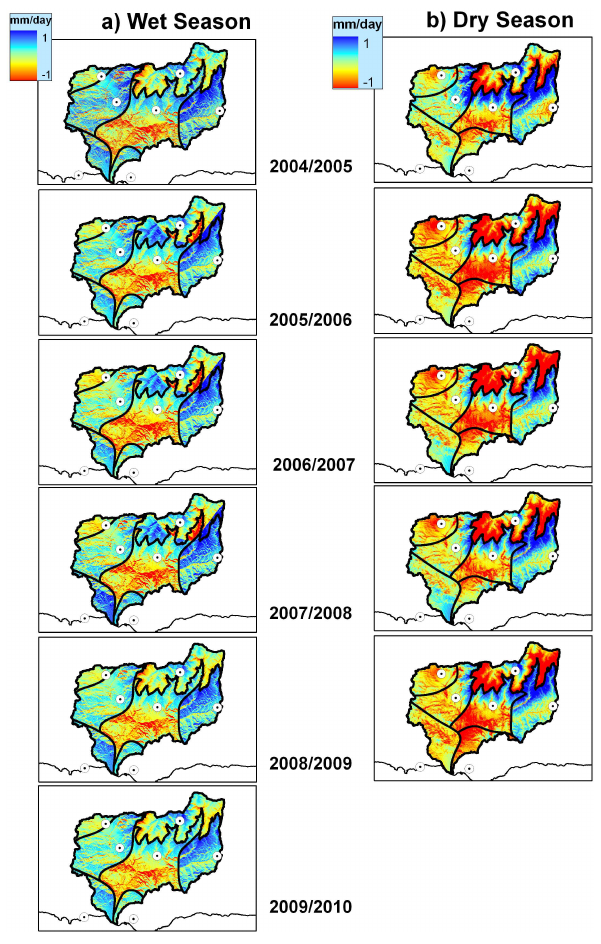
Fig. 8. Modified regions of influence and Hargreaves and differ- ences between ET 0 obtained by ASCE-PM and Hargreaves with adjusted coefficient allocated to modified regions of influence at the Guadalfeo river